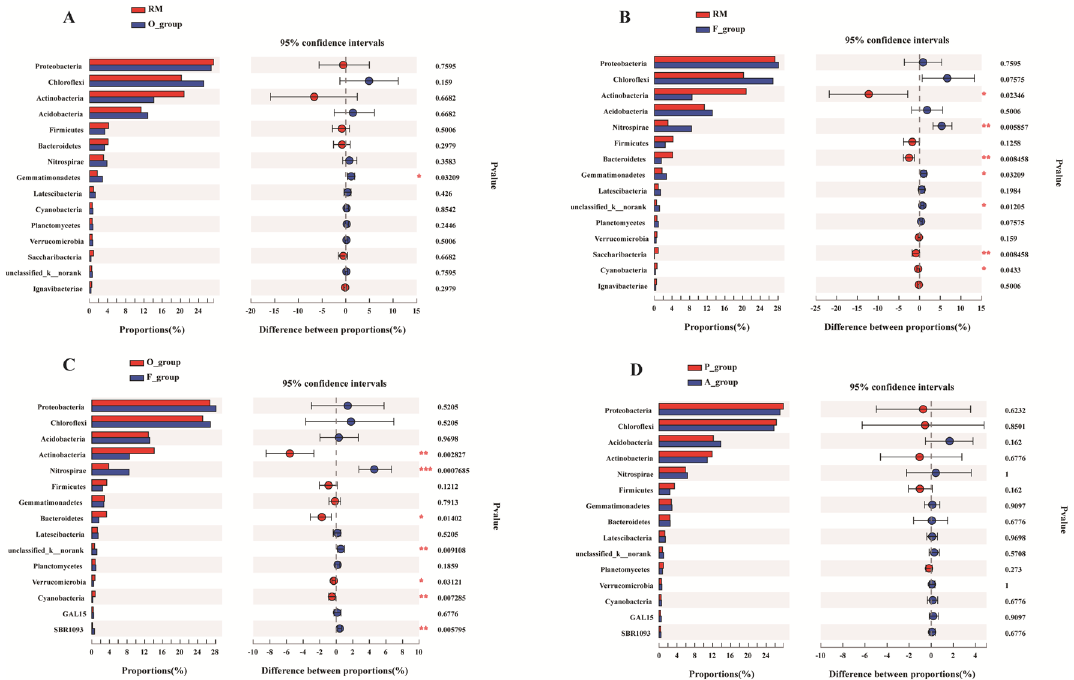
Figure 4. The differences with significance of the top 15 phyla between pairs of experimental groups (A: RM vs O_group, B: RM vs F_group, C: O_group vs F_group, D: P_group vs A_group; * indicates 0.01 < P ≤ 0.05, ** indicates 0.001 < P ≤ 0.01, *** P ≤ 0.001).